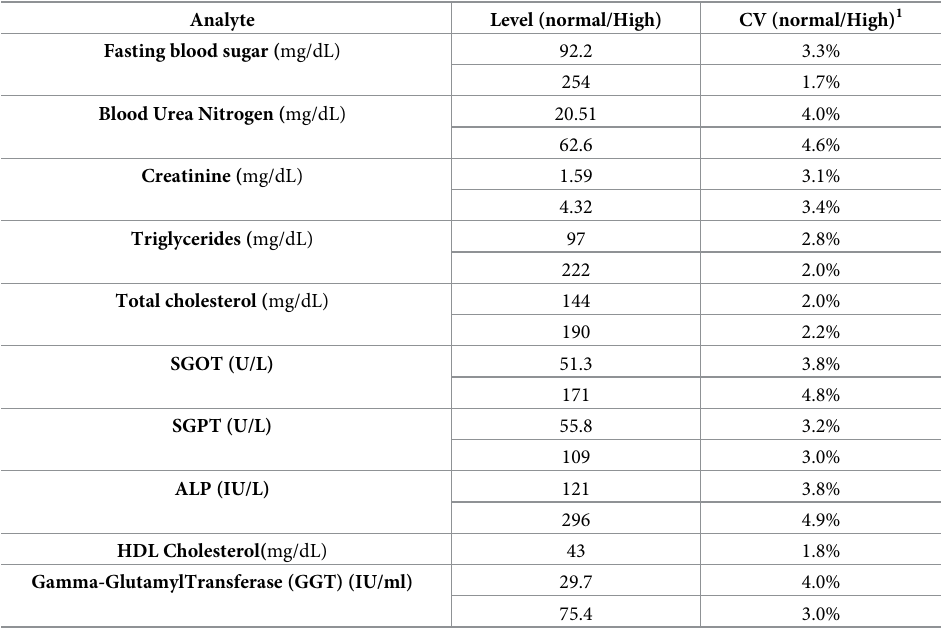
Table 4. Inter-assay coefficients of variation (CV) for biochemistry